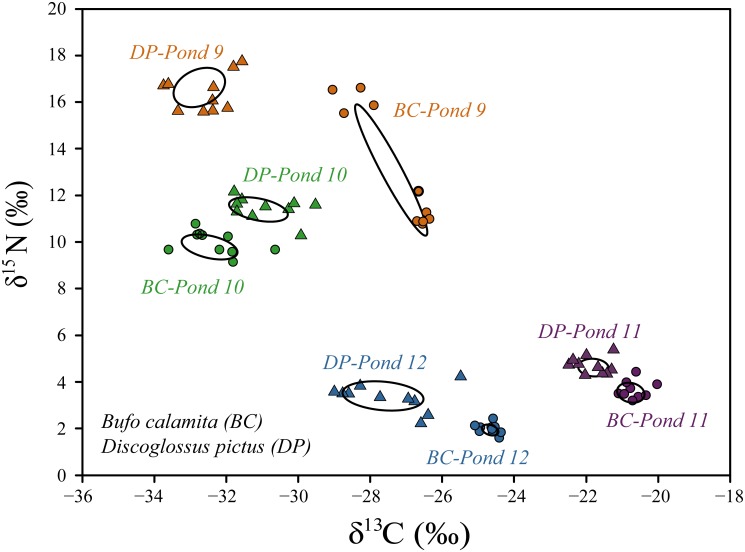
δ13C and δ15N values and standard ellipse areas for B. calamita and D. pictus in the four ponds where the species coexist (A-D).